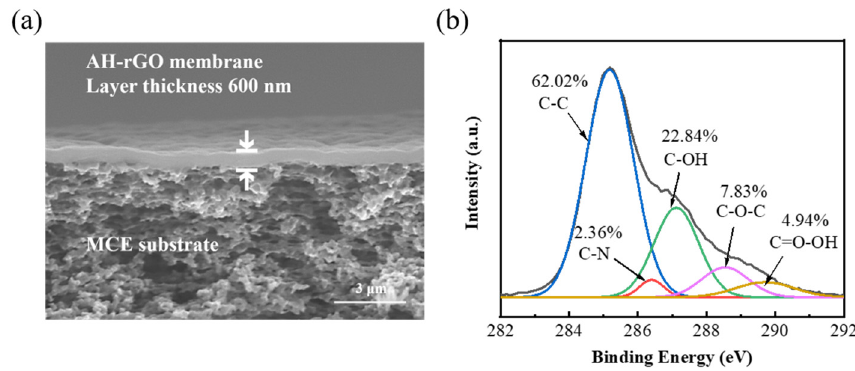
Figure 1. ( a ) SEM image of AH-rGO membrane. ( b ) XPS spectra of C1s for AH-rGO